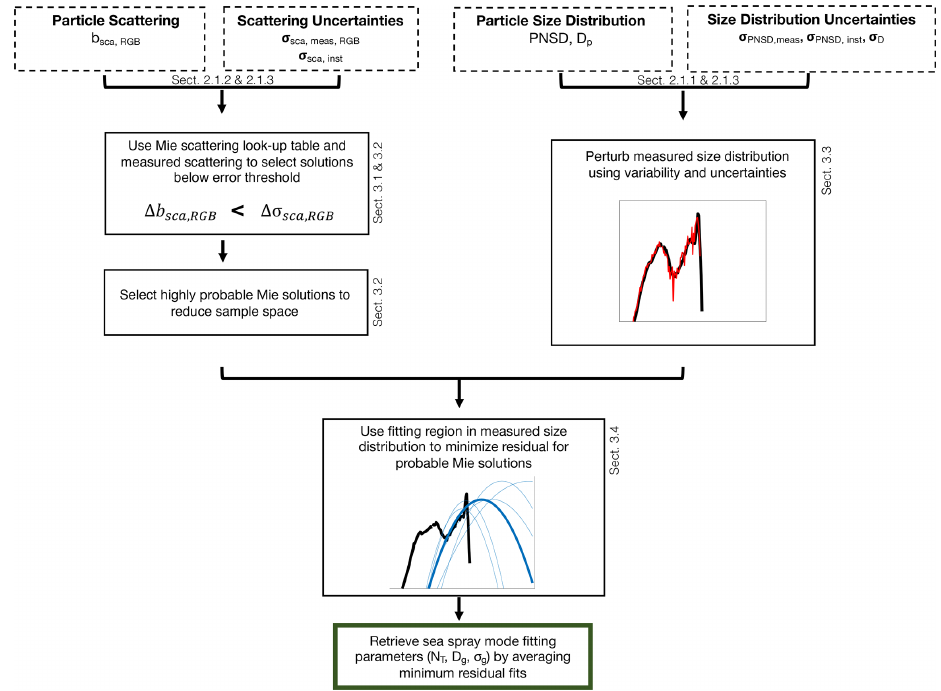
Figure 4. Flow chart describing the UHSAS-NEPH retrieval algorithm. The procedure associated with each step is described in the section cited either to the right of or below the relevant box.